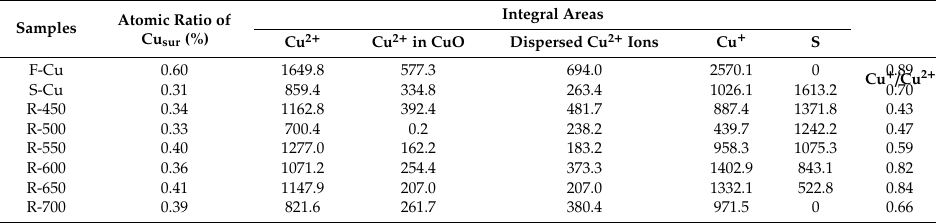
Table 2. The atomic ratio of surface Cu and integral areas of Cu 2p and S 2p determined from XPS spectra over Cu-SSZ-13 catalysts in fresh, sulfated and regenerated states.